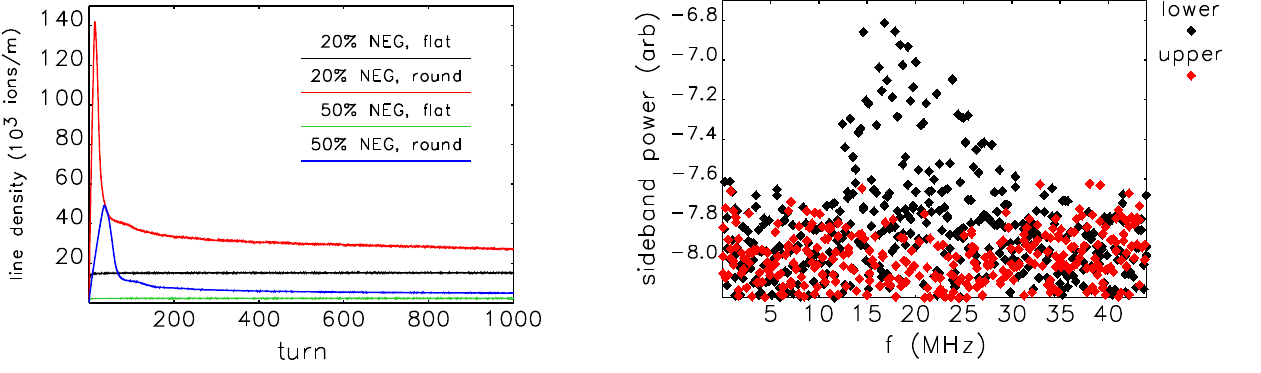
FIG. 8. Vertical betatron sidebands of the beam motion, 324 bunches, round beams, 200 mA, 50% NEG